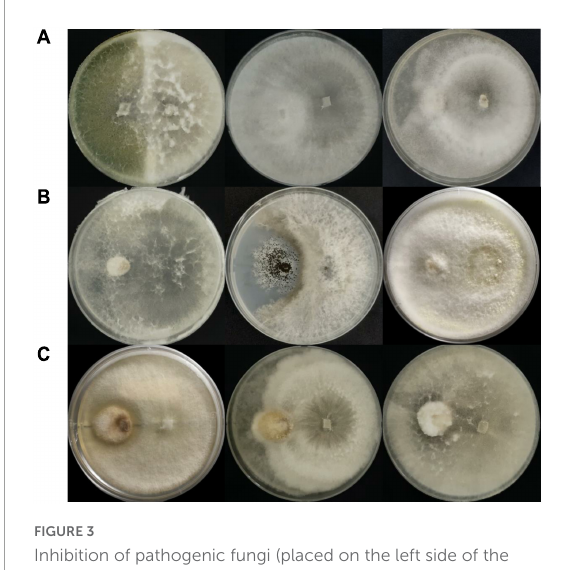
FIGURE3 Inhibition of pathogenic fungi (placed on the left side of the plate); inhibition of (A) Trichoderma viride , (B) Aspergillus niger , and (C) Fusarium sp. by endophytic fungi (placed on the right side of the plate) in dual culture plates. The three highest inhibition percentages for each pathogen were obtained from isolates (left to right): (A) 6407, 6413, and 6445; (B) 6407, 6399, and 6396; (C) 6395, 6411, and